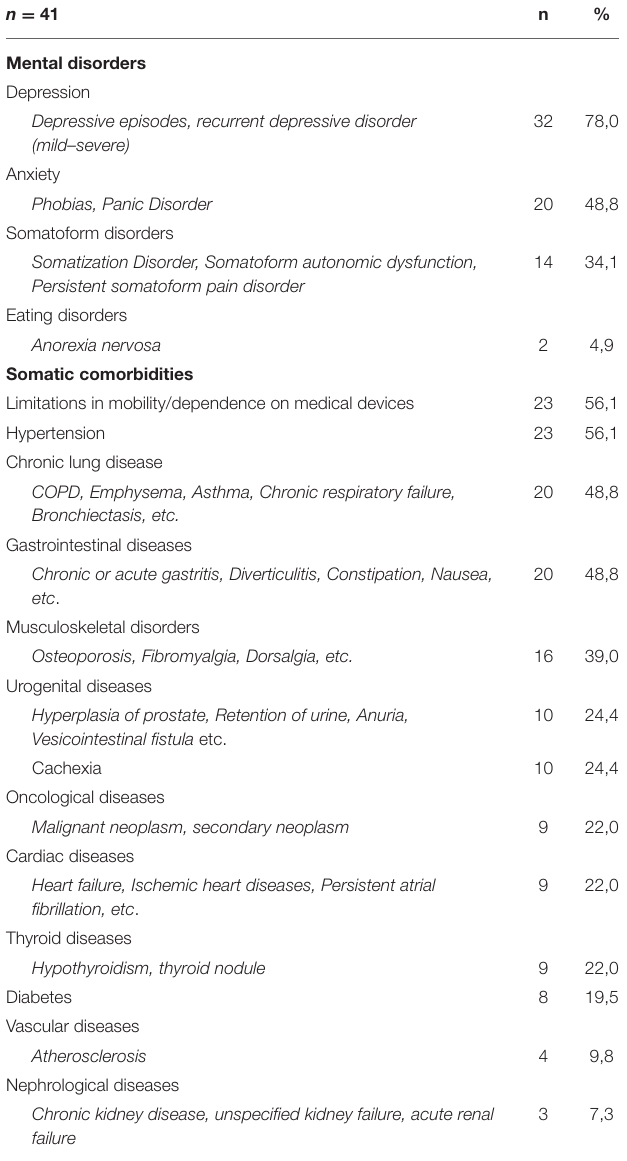
TABLE 2 | Diagnoses in NIPA